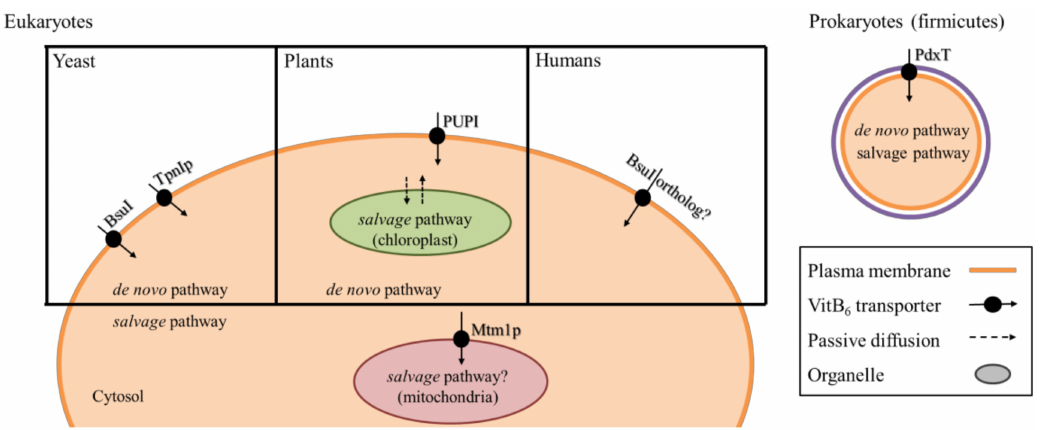
Figure 4. Schematic of known and potential vitB 6 transporters . In the yeasts S. cerevisiae and S. pombe , import of vitB 6 across the plasma membrane is facilitated by Tpn1p and Bsu1, respectively. In plants, members of the amino acid permease family (here PUP1) perform this function. In humans, there is no confirmed transporter for vitB 6 , but this may be accomplished by BsuI orthologs. In the bacterial phylum firmicutes, a modular transporter called PdxT transports B 6 vitamers into the cell. Mtm1p is a carrier from S. cerevisiae that imports PLP into the mitochondria. De novo and salvage pathways are labeled according to their presumed subcellular localization and presence in the respective